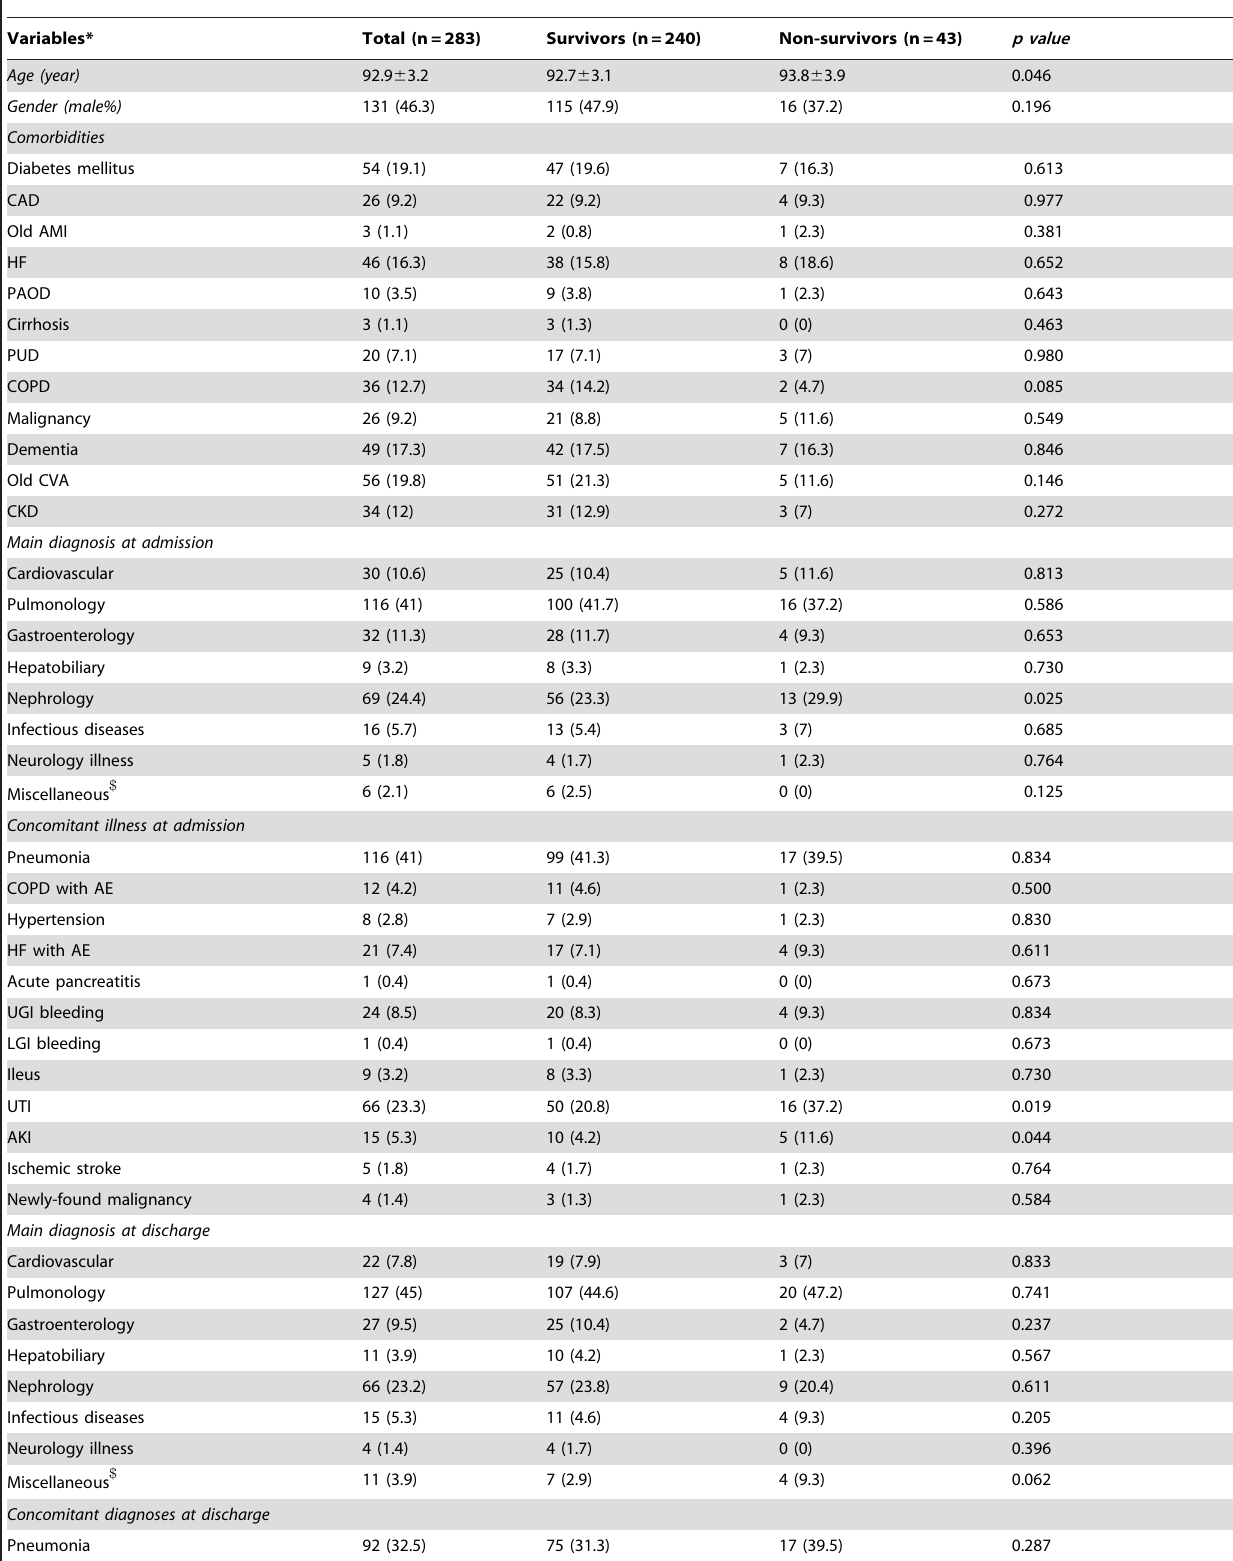
Table 4. Univariate analysis of factors associated with nonagenarian in-patient hospitalization mortality (percentage in